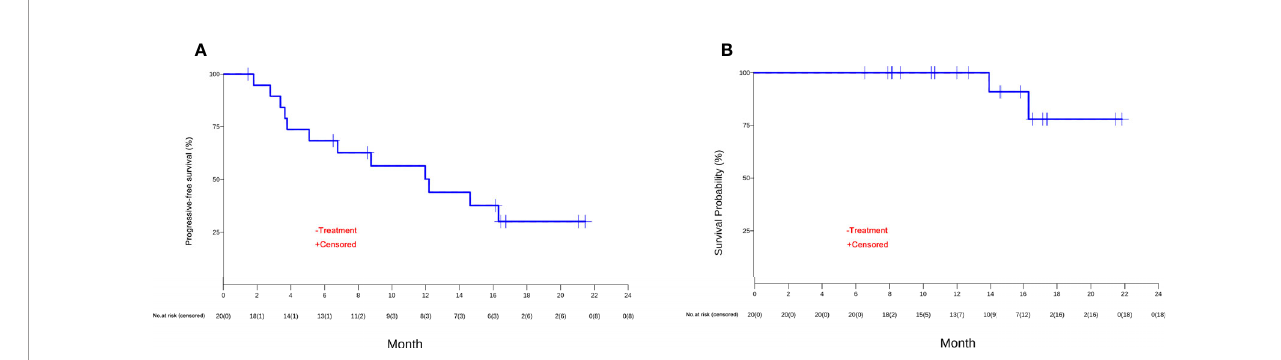
FIGURE 3 | The Kaplan-Meier curves of (A) progression-free survival (PFS) and (B) overall survival (OS) of unresectable or metastatic hepatocellular carcinoma patients in the ef fi cacy-evaluable population.